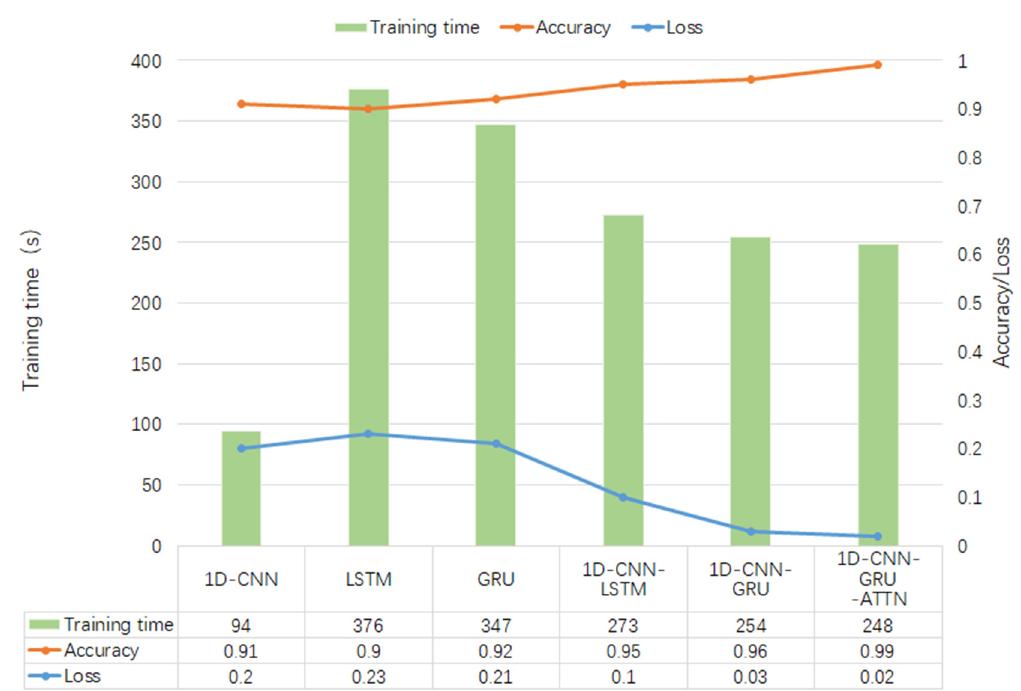
Figure 10. Results of comparative experiments on public dataset.